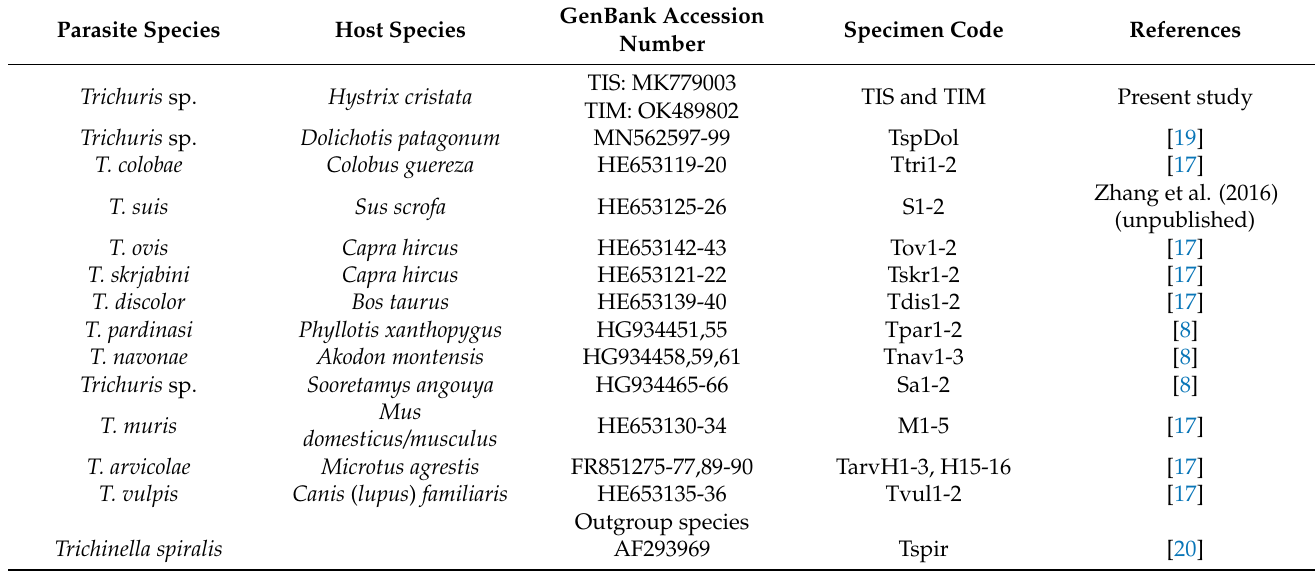
Table 1. List of materials analyzed in the present study for polymorphism analyses and phylogenetic inferences based on partial COX1 mitochondrial region. Information on parasite species as defined by authors, host species, GenBank accession numbers, Specimen codes and references are